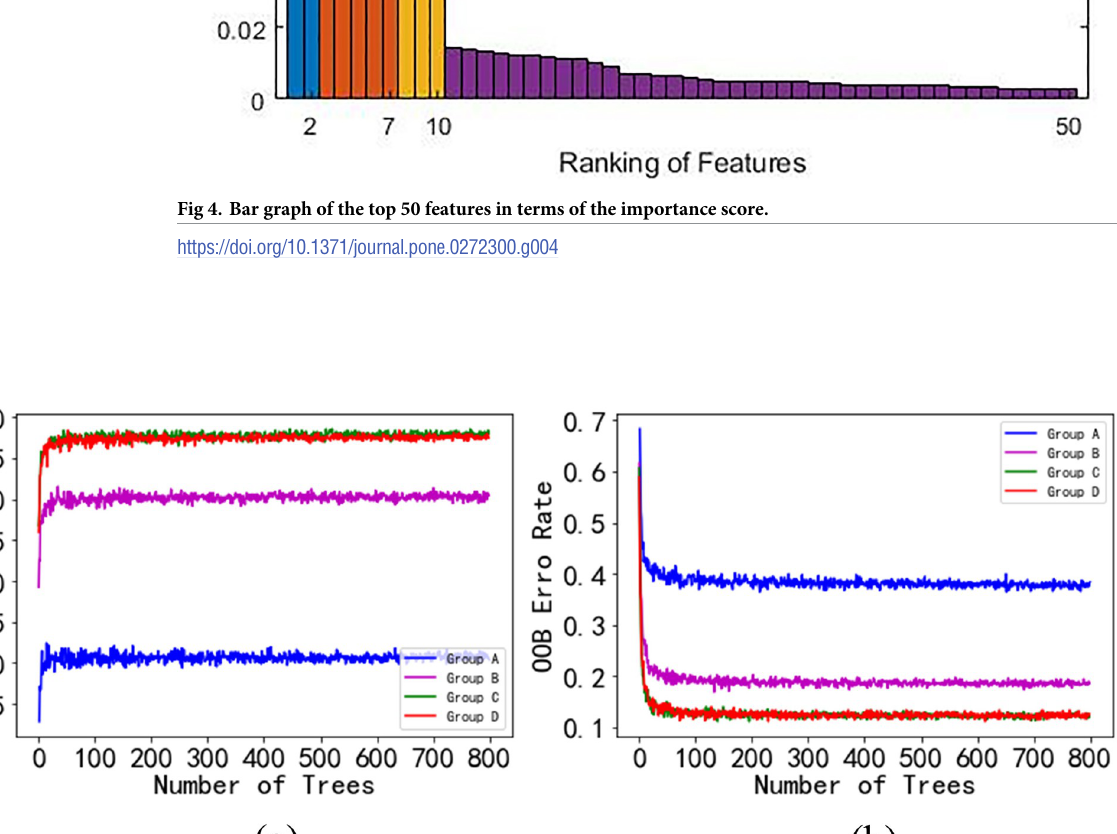
PLOS ONE | https://doi.org/10.1371/journal.pone.0272300 August 9,